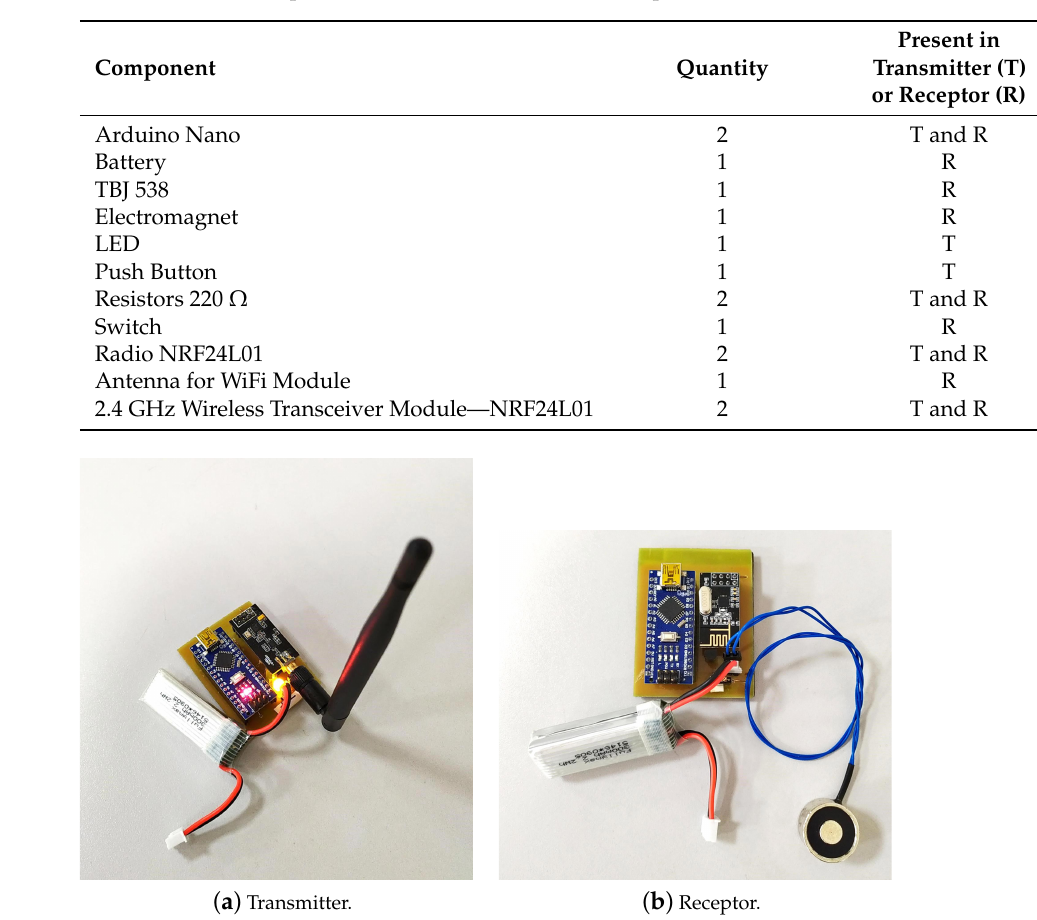
Figure 9. Printed circuit boards (PCBs) for electromagnet